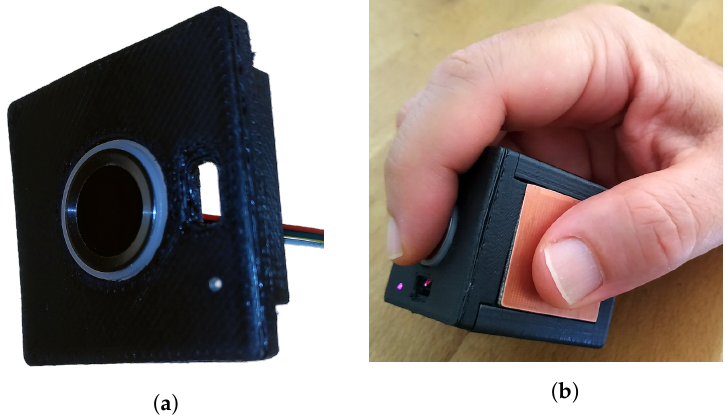
Figure 6. Fingerprint sensor: ( a ) fingerprint sensor module; ( b ) starting